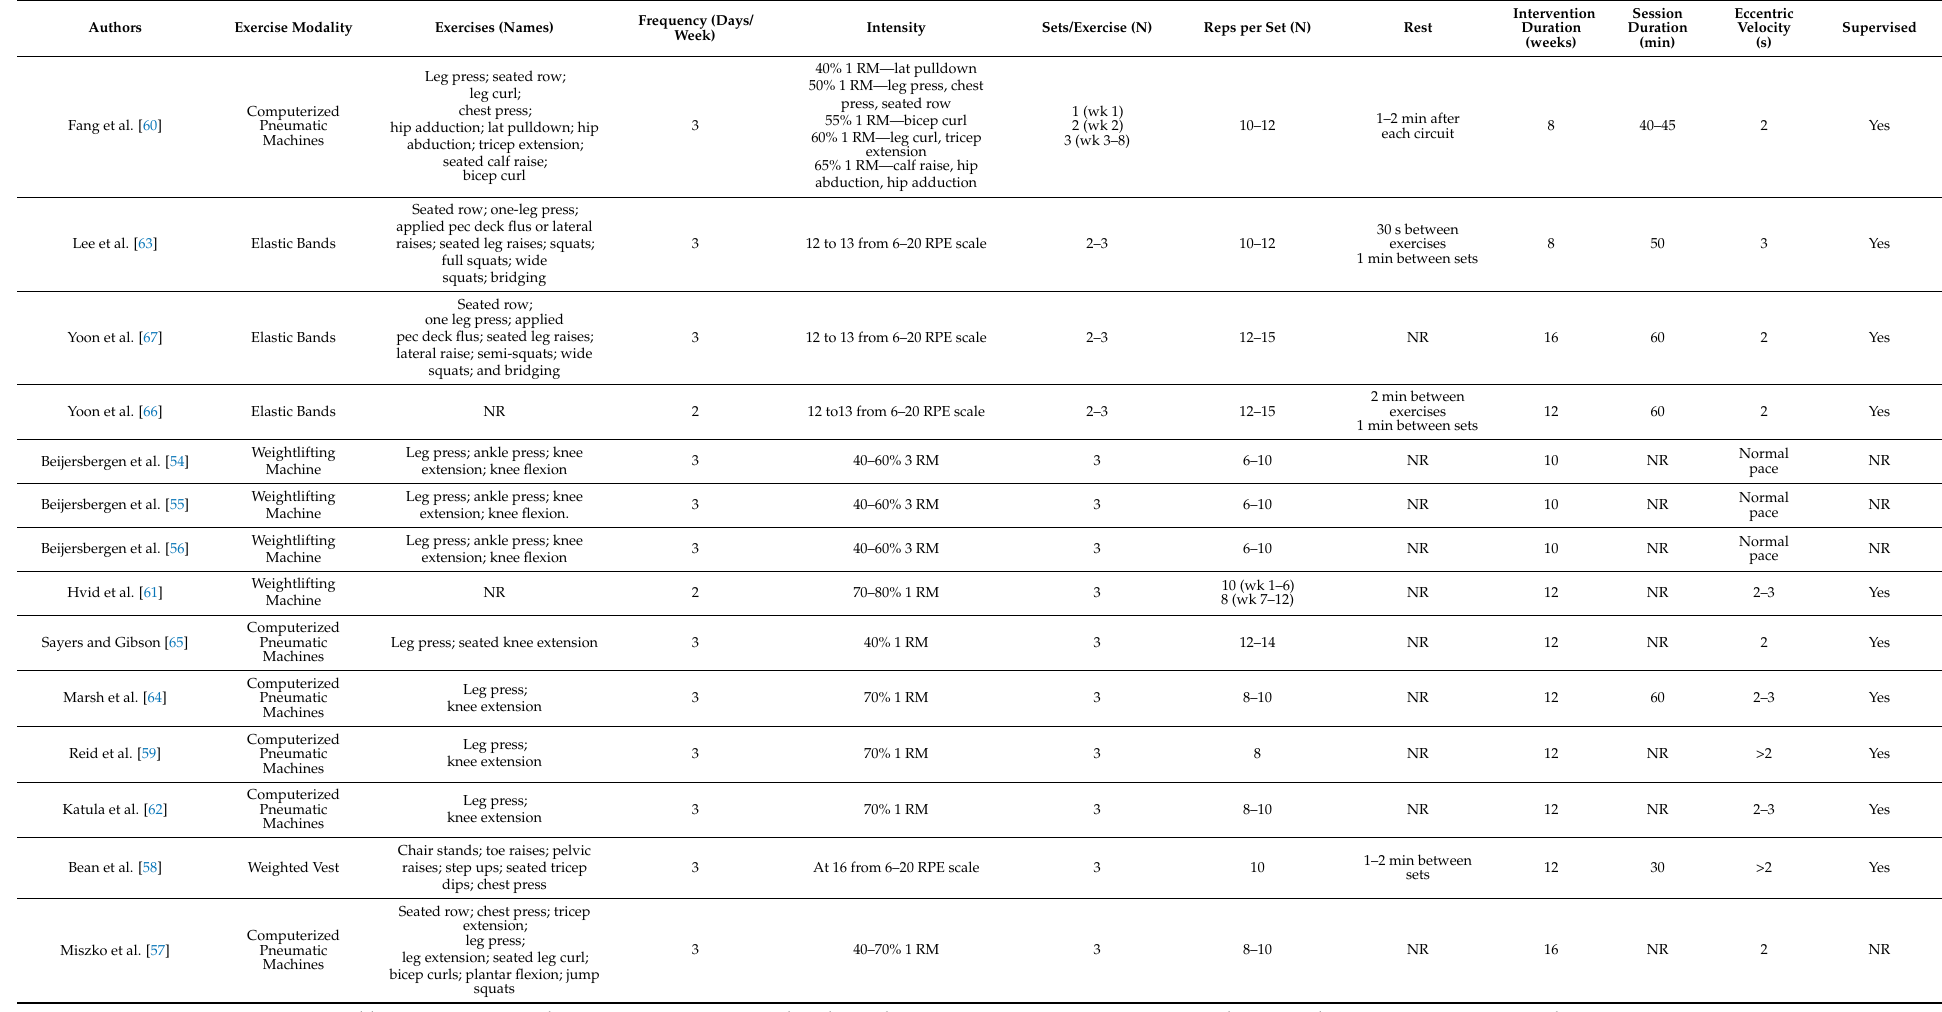
Table 3. Description of the interventions performed in the included